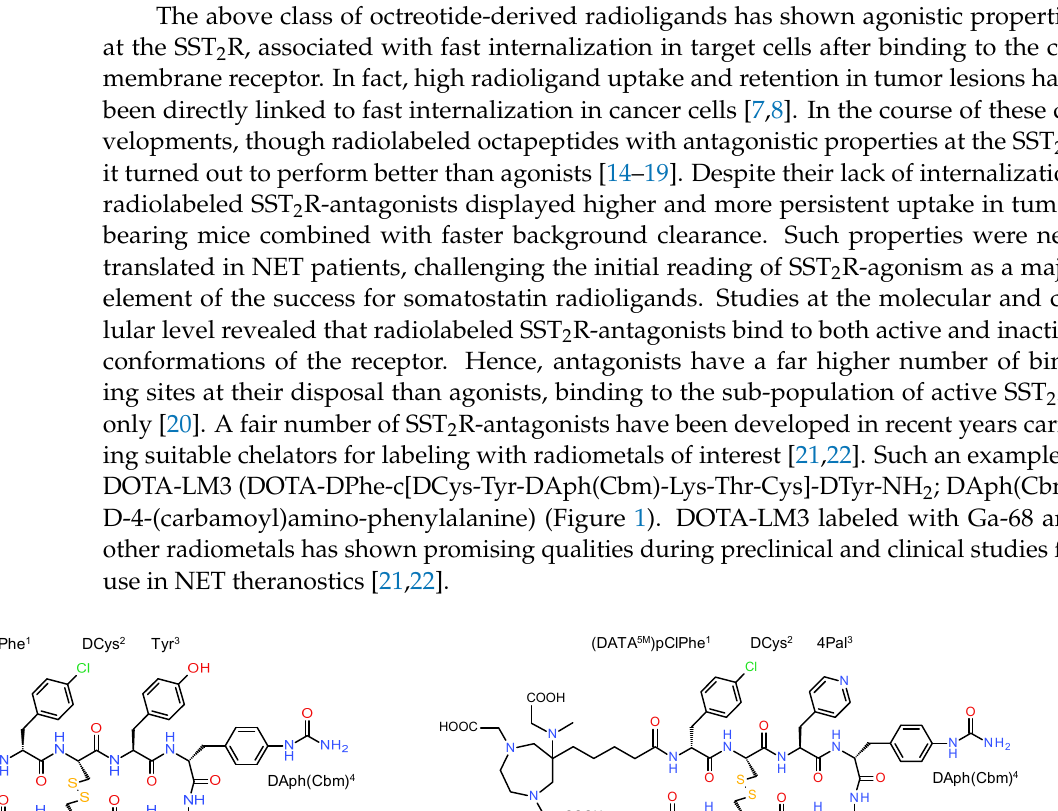
(Figure 1). In the present work, DOTA-LM3 and DATA 5m -LM4 were labeled with the longer- lived Ga-67 (t 1/2 : 78.3 h) surrogate for convenient and direct comparison of their preclinical profiles in HEK293-SST 2 R cells and HEK293-SST 2 R tumor-bearing mice. Moreover,